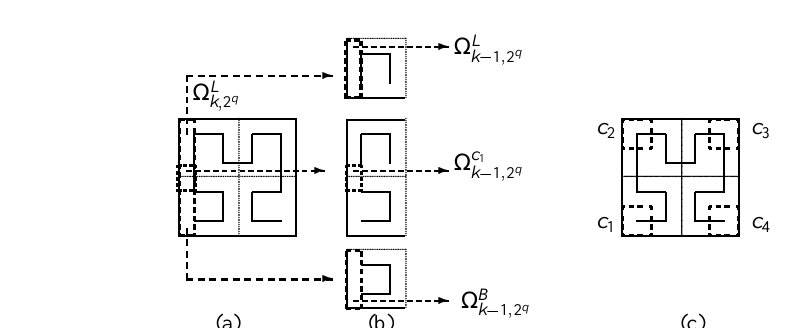
2 q 1 2 q 1 corners of a (cid:2) (cid:22) (cid:8) (cid:1)(cid:0) (cid:2) (cid:22) (cid:8)